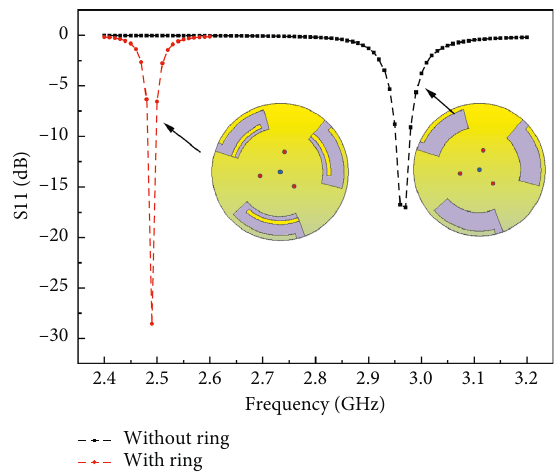
Figure 5: Comparison of with and without coupling ring.